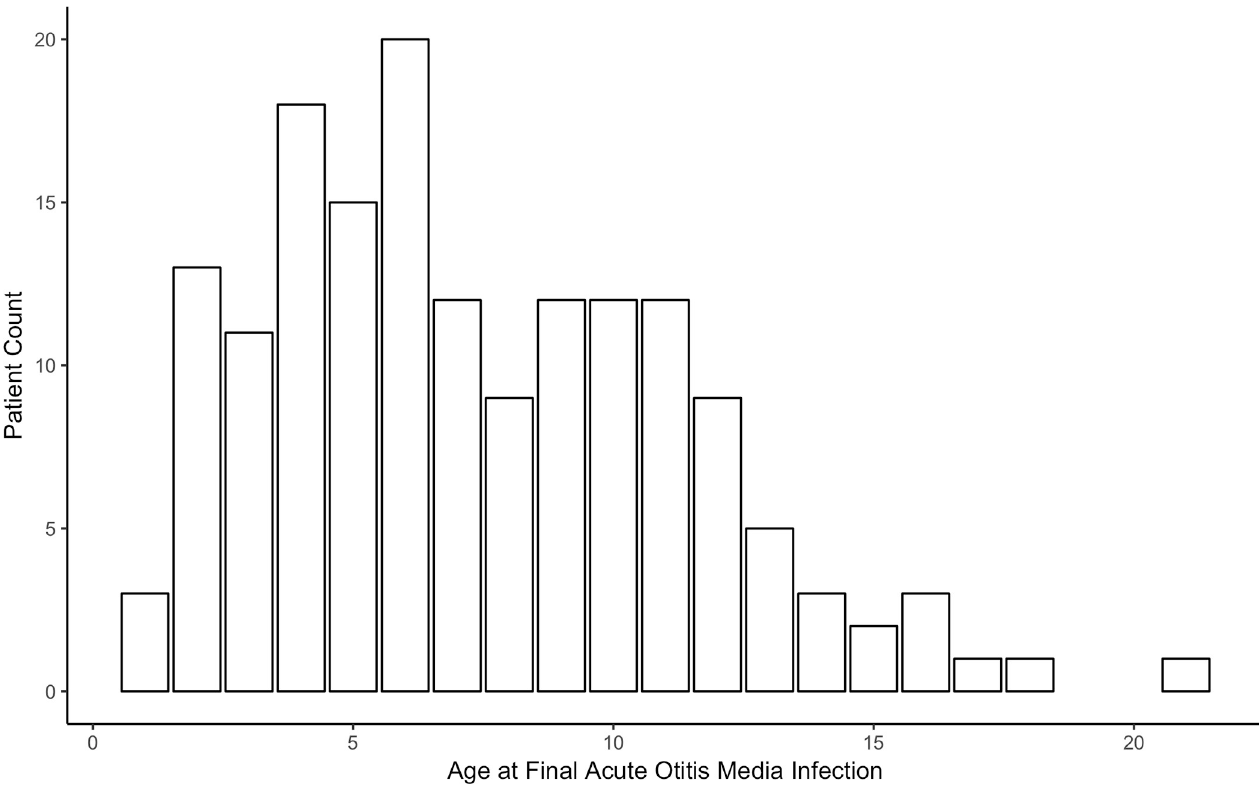
Fig 4. Age at final AOM infection. Histogram showing counts of patient ages at final AOM infection (N = 162).